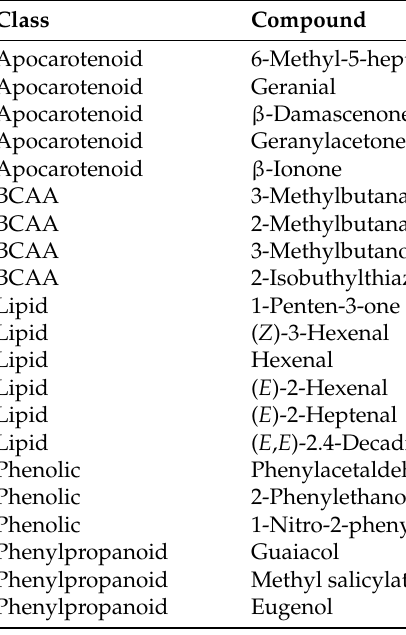
Table 1. Overview of the 21 main components of tomato aroma (adapted from [11]). * Odor descriptors were retrieved from the Good Scents Company database